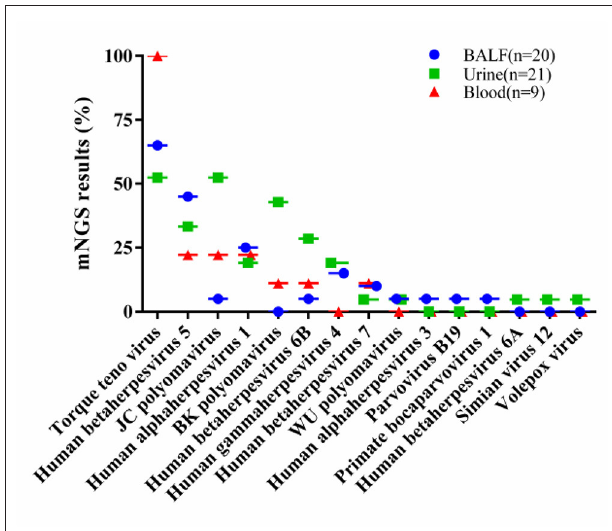
FIGURE 1 | The percentage of each virus in their respective samples, including 20 BALF samples, 21 urine samples and 9 blood samples. BALF, bronchoalveolar lavage fluids.